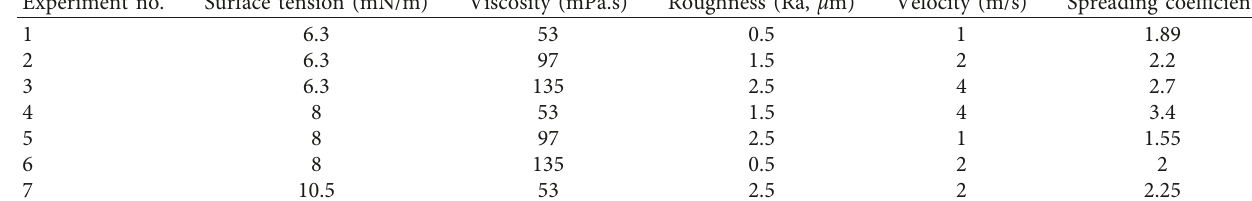
Table 2: Orthogonal tables and range analysis